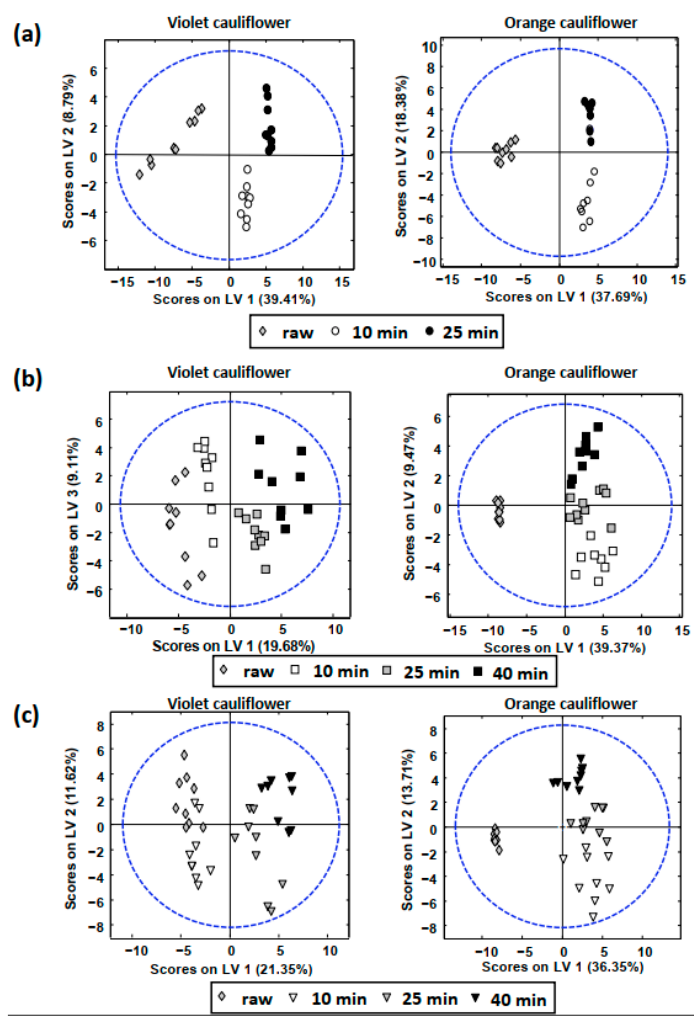
Figure 3. PLS-DA scores plots obtained using UHPLC–HRMS phytochemical as chemical descriptors to evaluate the classification of ( a ) boiled, ( b ) steamed, and ( c ) sous-vide samples, according to the cooking time employed.